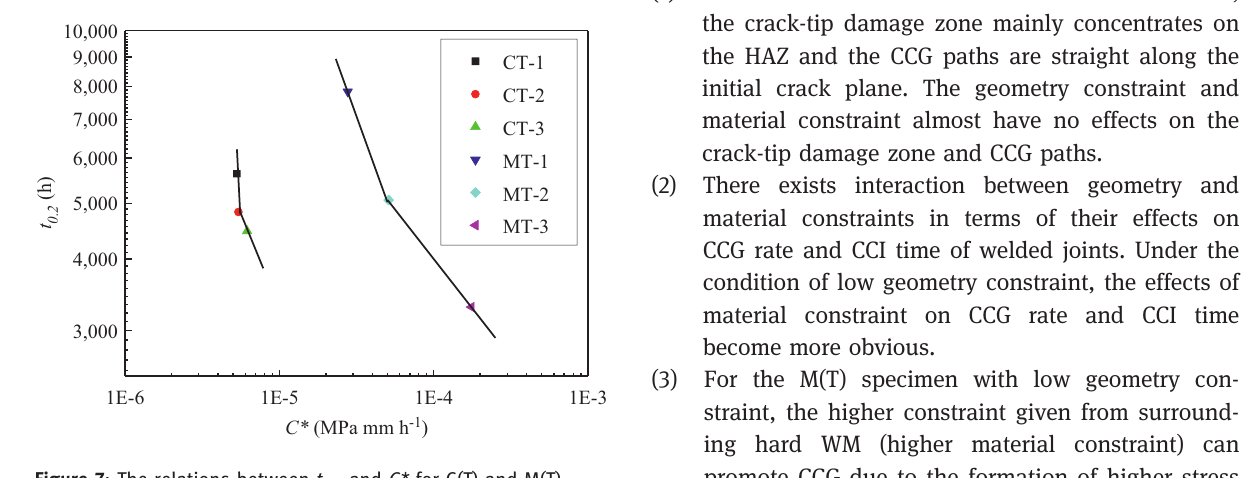
ffiffiffiffi p m